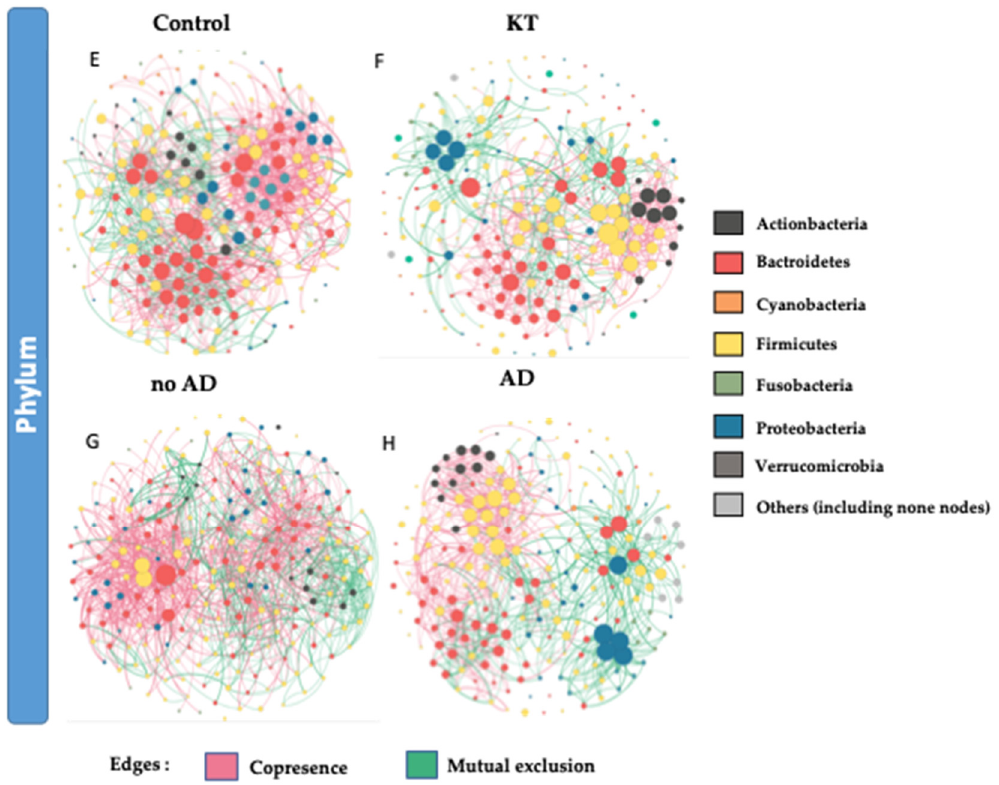
Figure 4. ( A , B , E , F ) Significant co-occurrence (red edges) and mutual exclusion (green edges) network analysis. Interactions among OTUs in the control group (n = 18) and patient group (n = 40). ( C , D , G , H ) Interaction among OTUs in no AD patients group (n = 16) and AD patient group (n = 24). For each group, the nodes correspond to the present OTUs colored according to phylum affiliation. The size of the nodes is proportional to their degree of connection (the number of edges associated to the node).